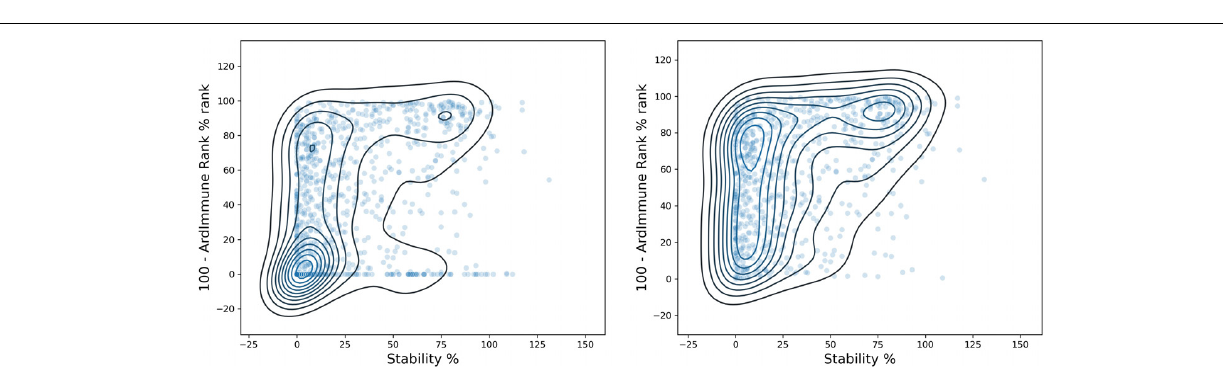
Frontiers in Genetics |